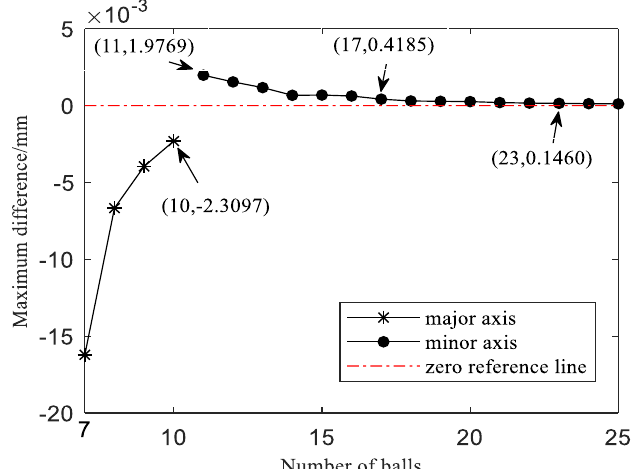
Fig. 11. Relationship of the maximum difference and number of balls